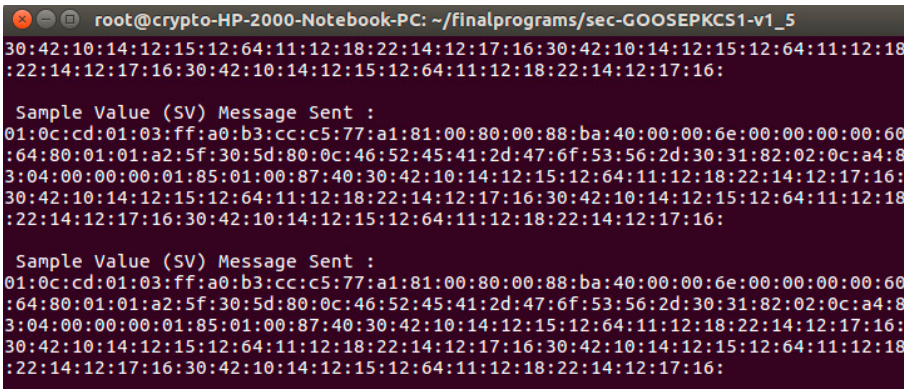
Figure 11. GoSV software program sending custom SV frames.